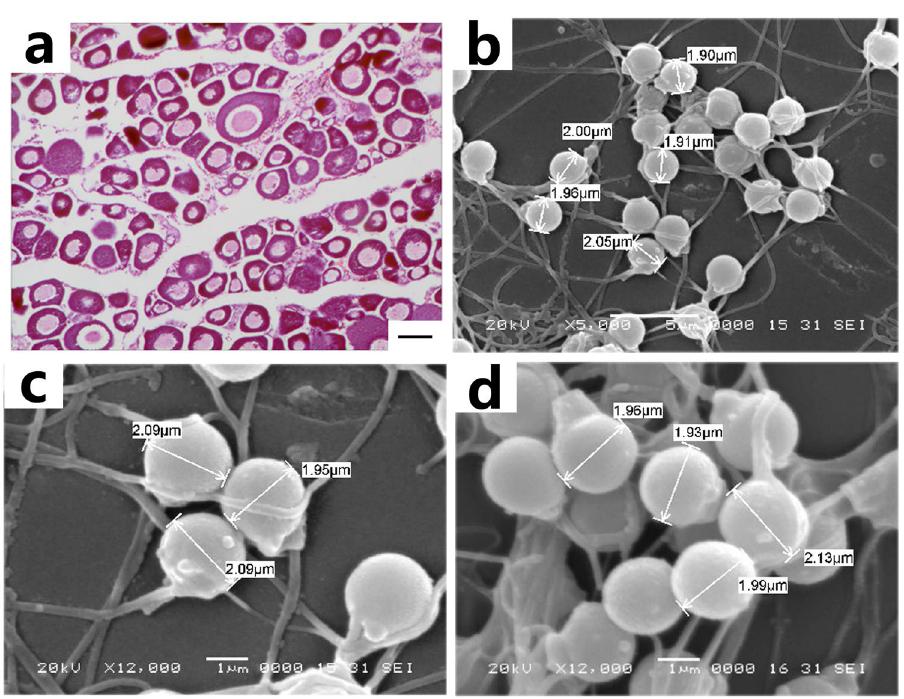
Figure 3. Ovarian microstructure of 2nNCRC and structure of 2nNCRC, 2nGCOC, and 2nGMCC sperm. ( a ) Ovarian microstructure of 2nNCRC; bar = 20 μ m. ( b ) Structure of 2nNCRC sperm under a scanning electron microscope; bar = 5 μ m. ( c ) Structure of 2nGCOC sperm under a scanning electron microscope; bar = 1 μ m. ( d ) Structure of 2nGMCC sperm under a scanning electron microscope; bar = 1 μ